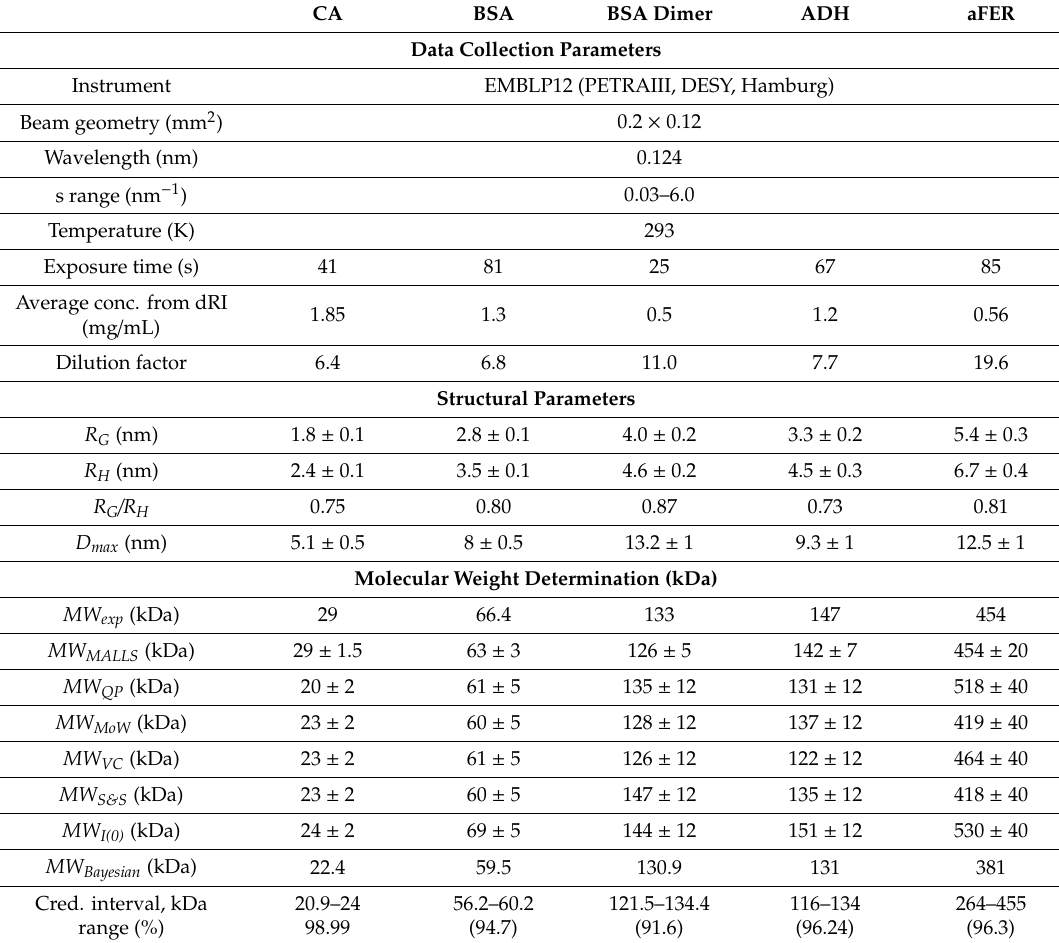
Table 2. SAXS data collection, statistics, and overview of biophysical and SAXS-derived parameters. CA BSA BSA Dimer ADH